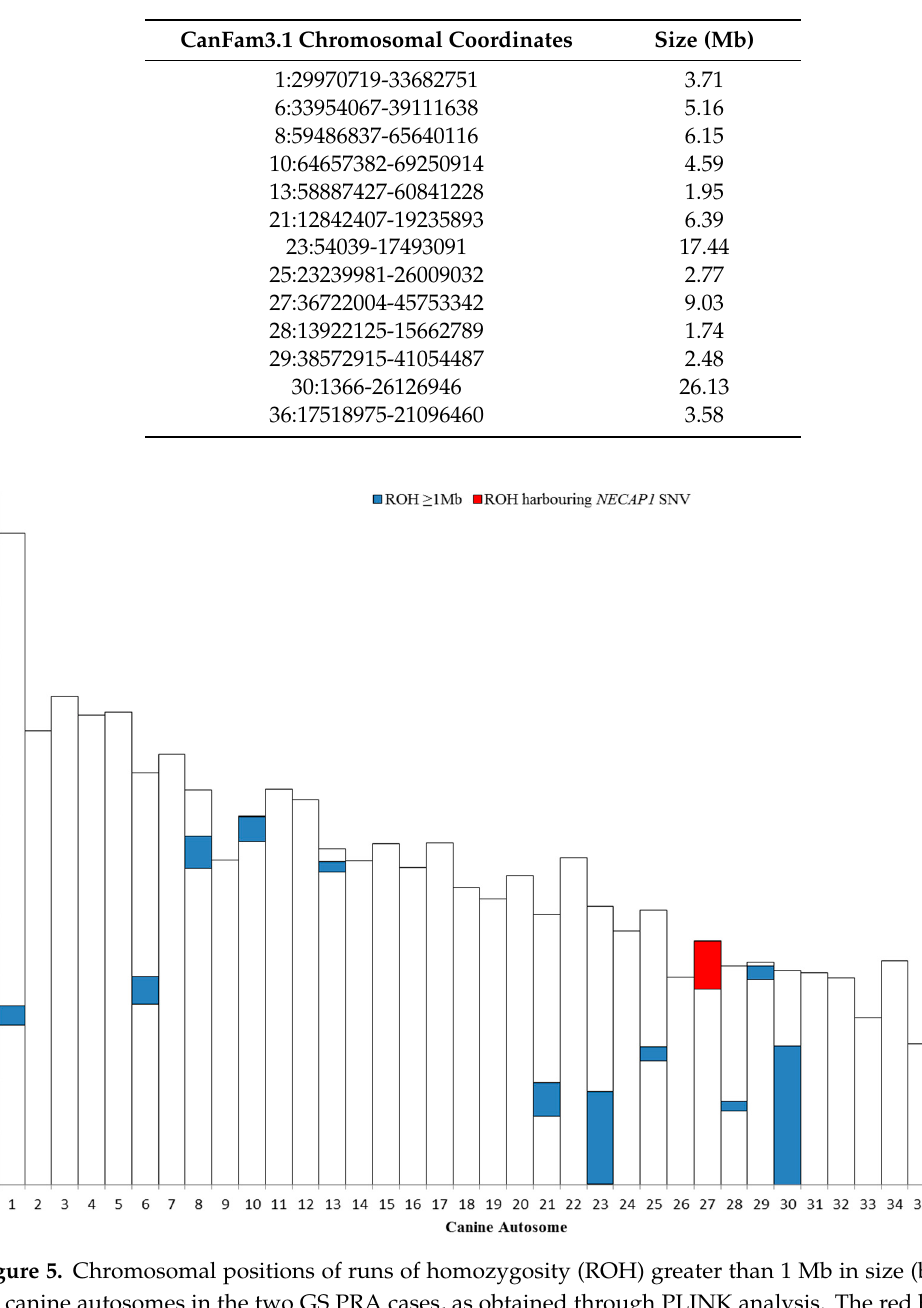
Table 3. PLINK analysis identified 13 runs of homozygosity (ROH) exceeding 1 Mb in size present in both PRA a ff ected GS dogs. The NECAP1 single nucleotide variant (SNV) lies within the 9.03 Mb ROH identified on chromosome 27.